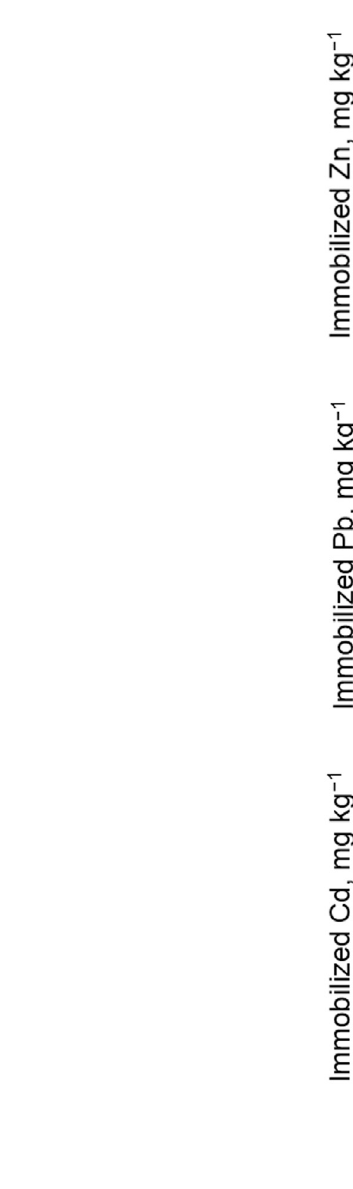
FIGURE 2 Langmuir modelsused topredictthemaximum immobilizationofheavymetals.Noline meansanon-signi fi cant fi tofthemodel.Barsrepresentthe standarddeviationofthemean( n =3).Pointsbelowthereddashedline(negativevalues)meanthatheavymetalbecomesmoreavailablethanthecontrol treatment(0%biocharapplication).I MAX =maximumimmobilizationforthe fi ttedmodel.Valuesfollowedby±arethestandarddeviation.**: p < 0.01;***: p < 0.001. SimpleLangmuiradsorptionisothermequation : y (cid:1) ( a * b * x ) / ( 1 + b * x